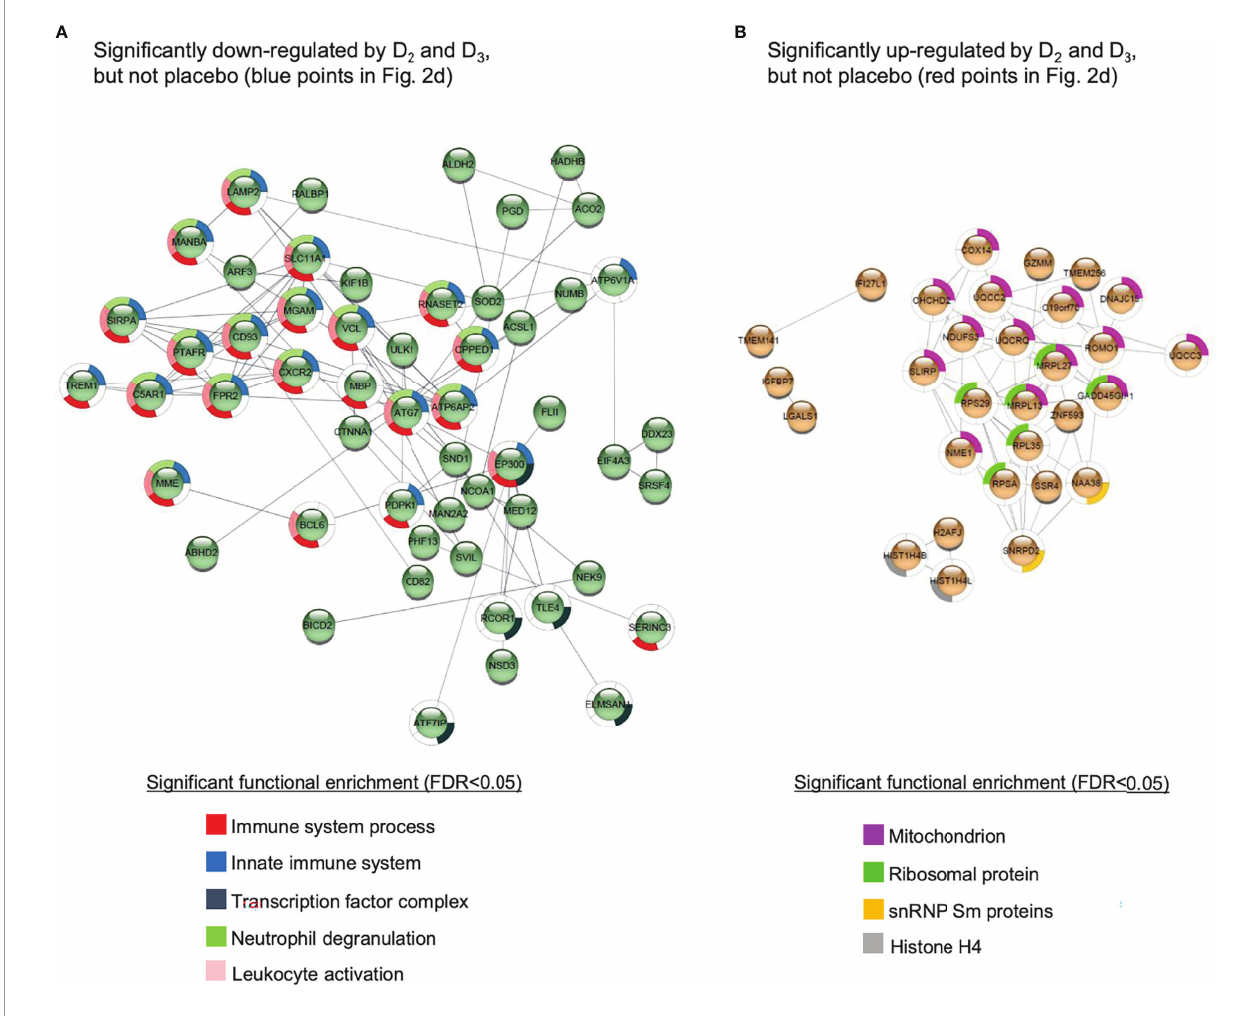
FIGURE 3 | Protein-protein interaction networks for gene products corresponding to the probes (A) signi fi cantly down-regulated or (B) signi fi cantly up-regulated in both the D 2 and D 3 treatment groups of the WE cohort, but not the placebo group. Details given in Supplementary Data File 3 . The networks were generated using the STRING database of Homo sapiens medium con fi dence (0.4) interactions, and only connected nodes are shown. Networks for both (A, B) are signi fi cantly enriched for interactions compared to randomised sets, yielding p-valuesof 1.98 × 10 -6 and 4.99 ×10 -9 ,